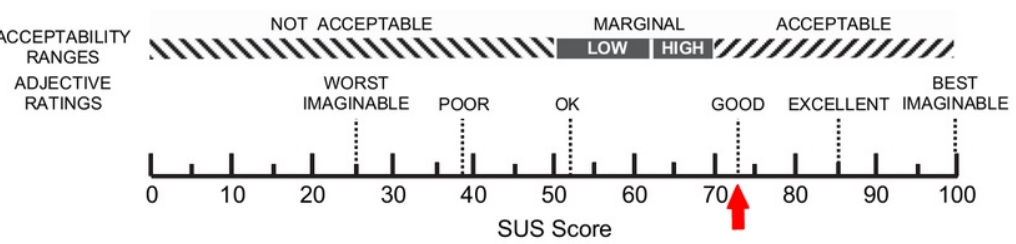
Figure 9. A representation of System Usability Scale (SUS): The red arrow indicates RecAAL’s score.